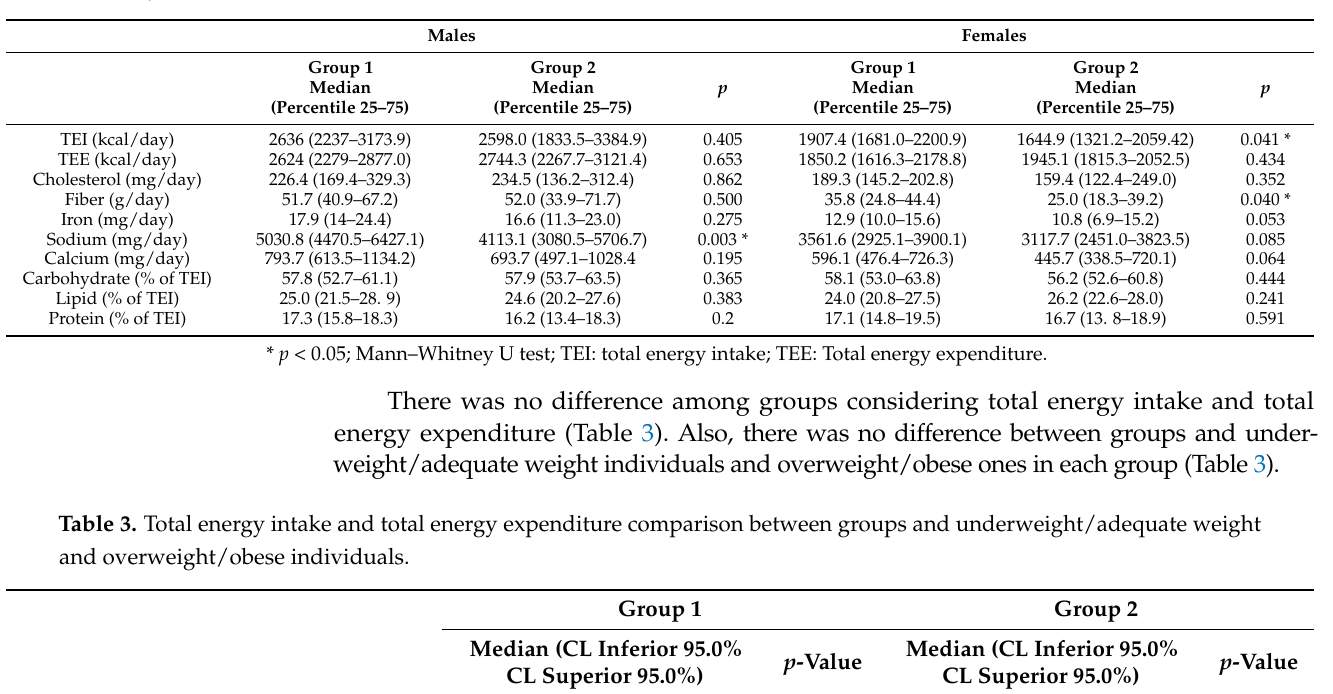
Table 2. Central tendency and variance of nutritional composition of intake by sex and group of university students from university restaurant (UR).